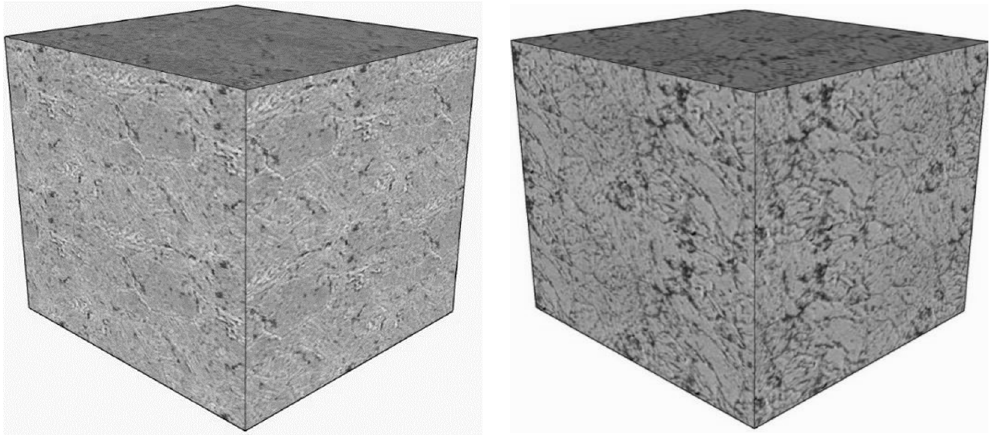
Figure 6. Microstructure of the 2.25Cr-1Mo ( left ) and 3Cr-1Mo-0.25V ( right ).